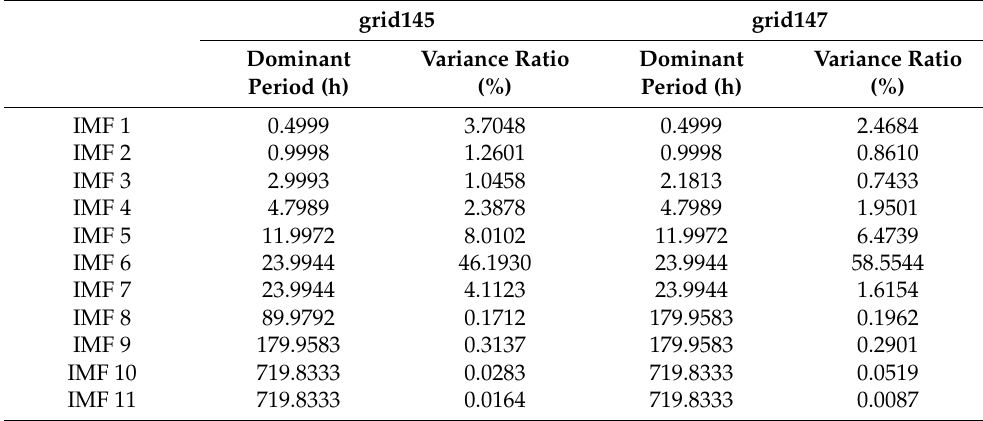
Figure 5. EEMD decomposition results. (Note: The time series at the top is the original series, followed by IMF 1 to IMF 11 and the residual). Table 3. IMF information for grid145 and grid147.